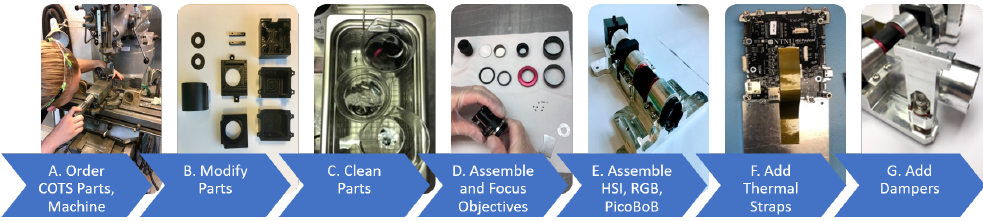
Figure 9. Simplified assembly sequence for the HYPSO-1 payload at